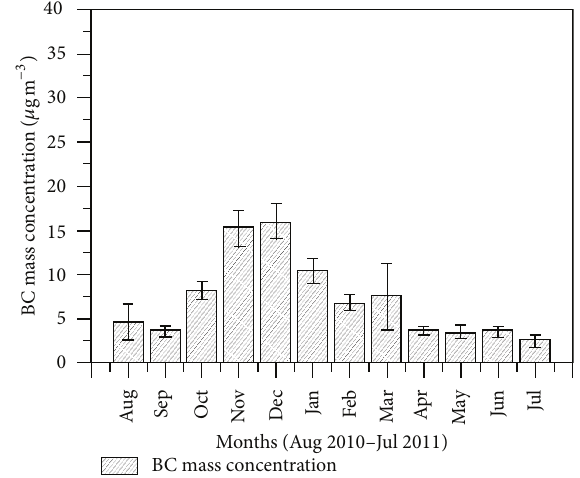
Figure 2: Monthly mean variation of BC mass concentration during August 2010–July 2011 over